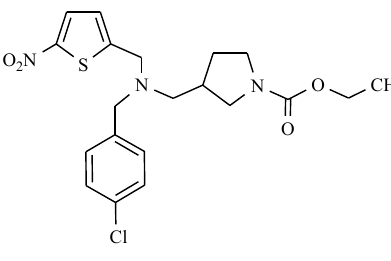
Figure 25. The structure of SR9009.